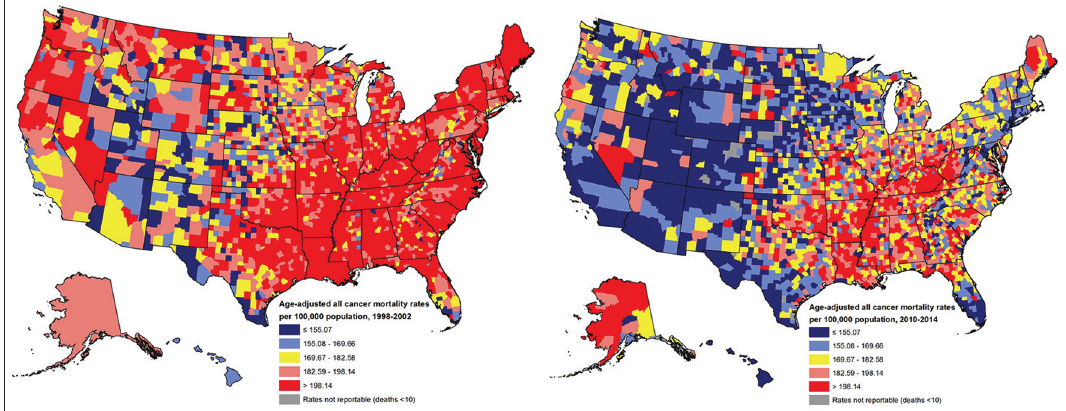
Fig ure 16. Age-Adjusted All-Cancer Mortality Rates per 100,000 Population for the United States (3,143 Counties), 1998-2002 and 2010-2014 Source: Derived from the 1998-2014 National Vital Statistics System.